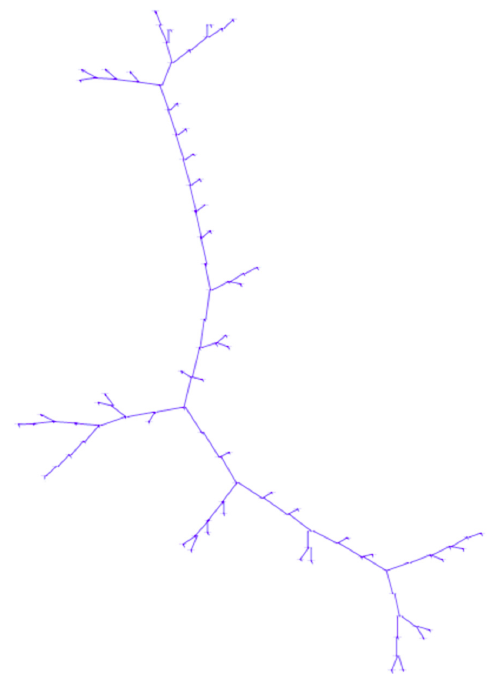
Figure 1. Abstract graphical representation of the network.